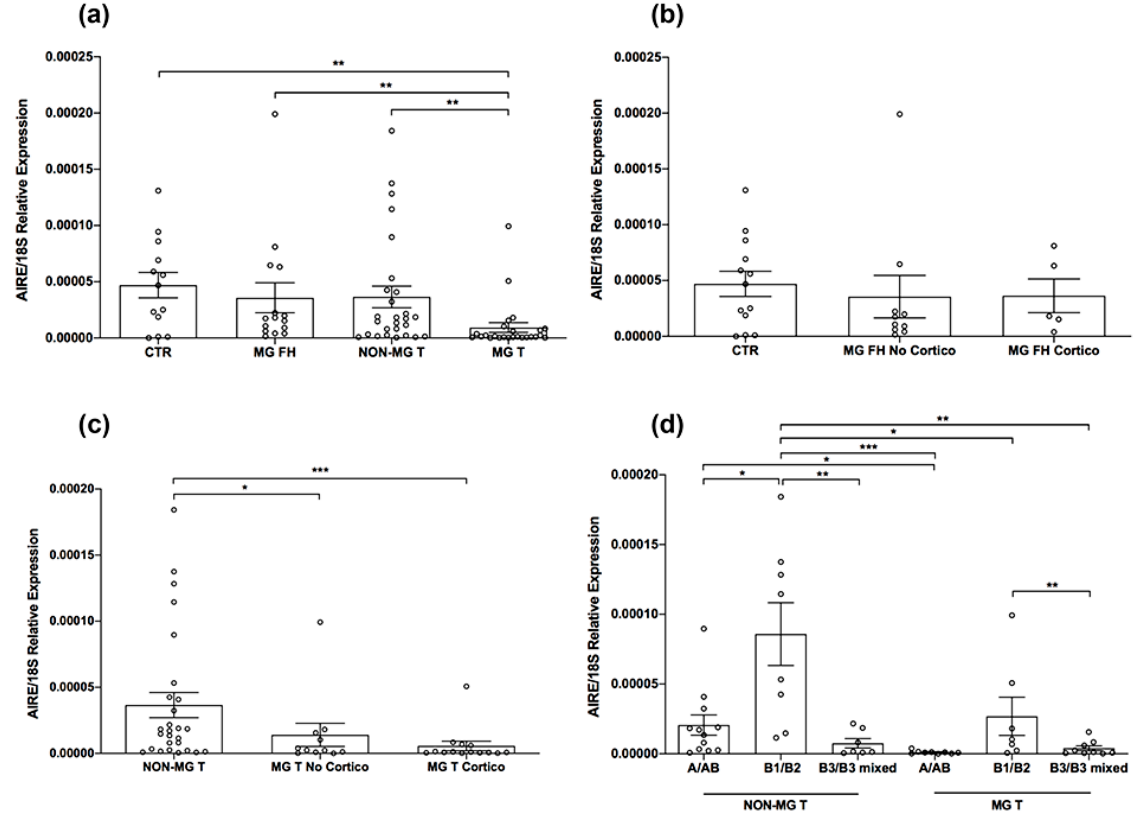
Figure 3. AIRE expression in MG and control thymuses. ( a ) AIRE mRNA levels were assessed in normal thymuses (CTR), follicular hyperplastic MG (MG FH) thymuses, thymomas from non-MG patients (NON-MG T), and MG thymomas (MG T). ( b ) AIRE mRNA levels in MG FH thymuses from corticosteroid-naïve (MG FH No Cortico) and -treated (MG FH Cortico) patients compared to CTR. ( c ) AIRE mRNA levels in MG T from corticosteroid-naïve (MG T No Ccortico) and -treated (MG T Cortico) patients compared to NON-MG T. ( d ) AIRE mRNA levels in NON-MG T and MG T stratified according with WHO thymoma type. In the graphs, AIRE expression levels were expressed as relative values (2 −Δ Ct × 100) normalized toward the endogenous 18S. Mann–Whitney test, * p < 0.05; ** p < 0.01; and *** p < 0.001.